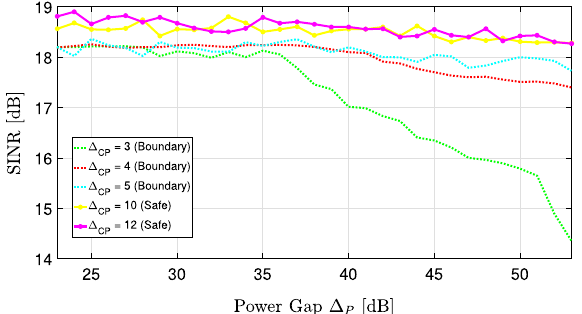
Fig. 18 This plot also represents Case II, i.e., fixing (cid:31) CP and varying (cid:31) p , but for only the boundary and safe 3,4,5,10,12 regions, i.e., (cid:31) CP . Zooming in to see their = { }